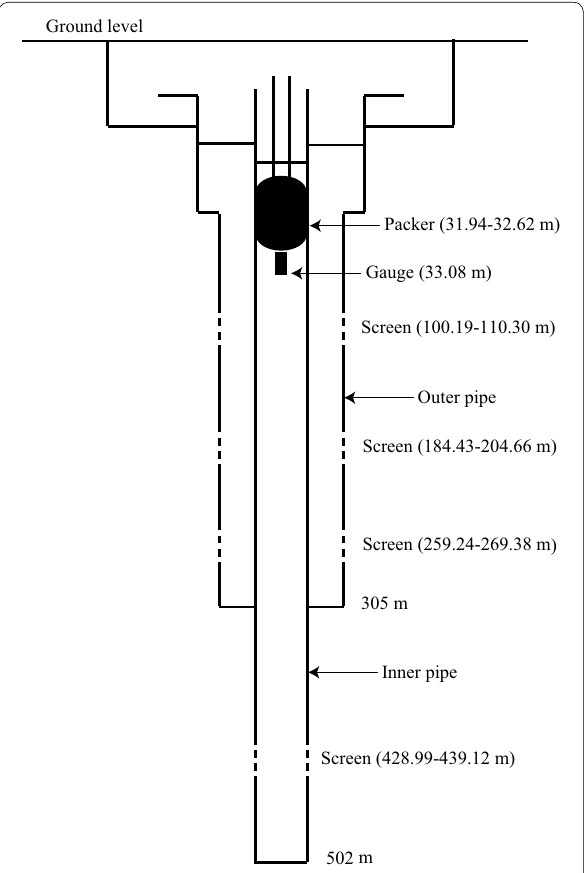
Fig. 2 Schematic representation of the double-pipe observation well at HKS. The screen depths and the installation depth of the packer and water pressure gauge (sensor) are